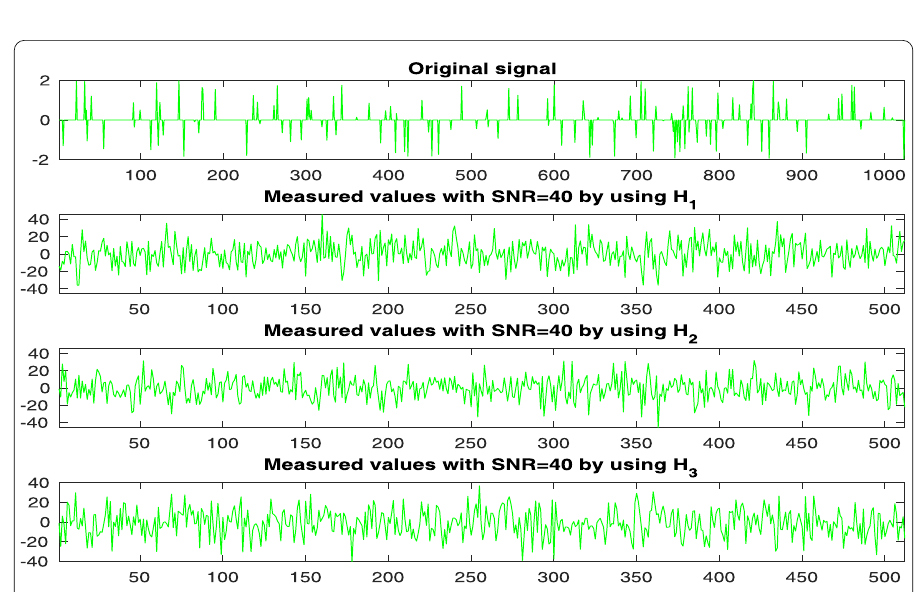
Figure 6 From top to bottom: the original signal and the measurement by using H 1 , H 2 , and H 3 , respectively, with m = 128